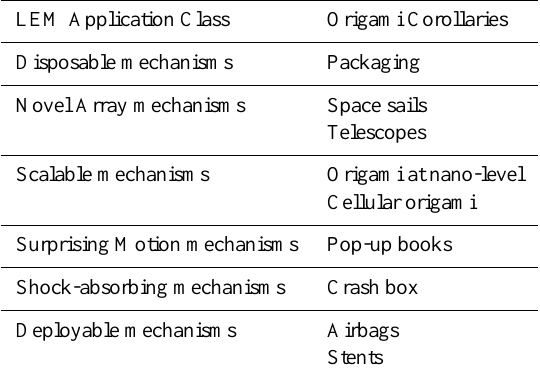
Table 1. Origami Applications by LEM Technology Category.